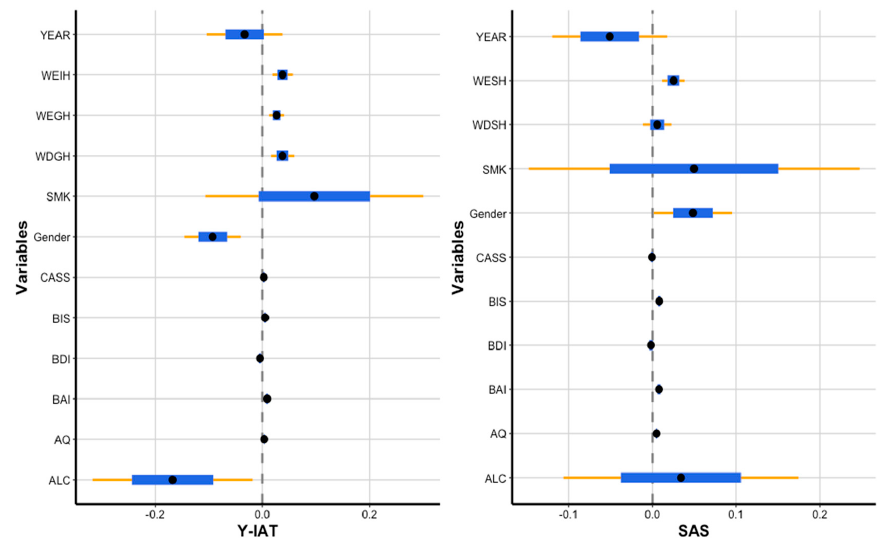
Figure 3. The plots of regression coefficients when fitting the t-copula, ( a ) Internet Addiction Test (Y- IAT) part and ( b ) Smartphone Addiction Scale (SAS) part.